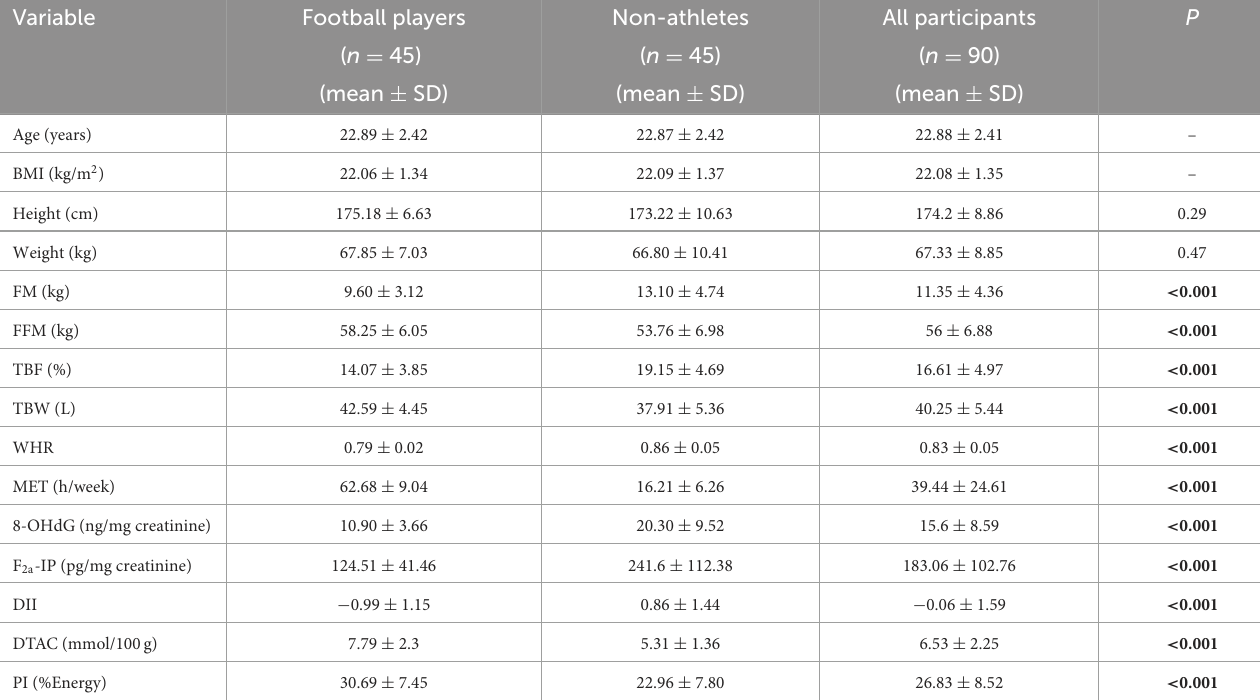
TABLE 1 Baseline characteristics of the study participants.